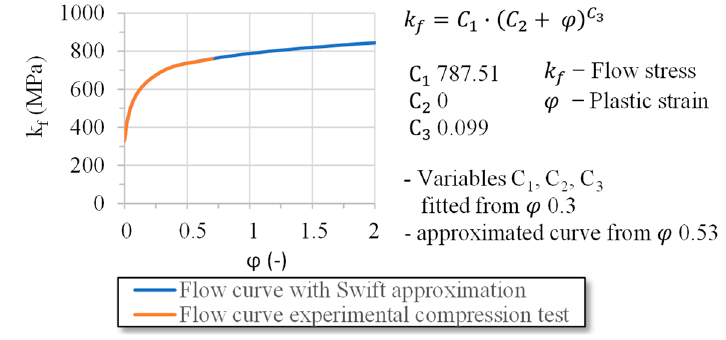
Figure 4. Flow curve S355 k f ( φ ) for the FE simulations.